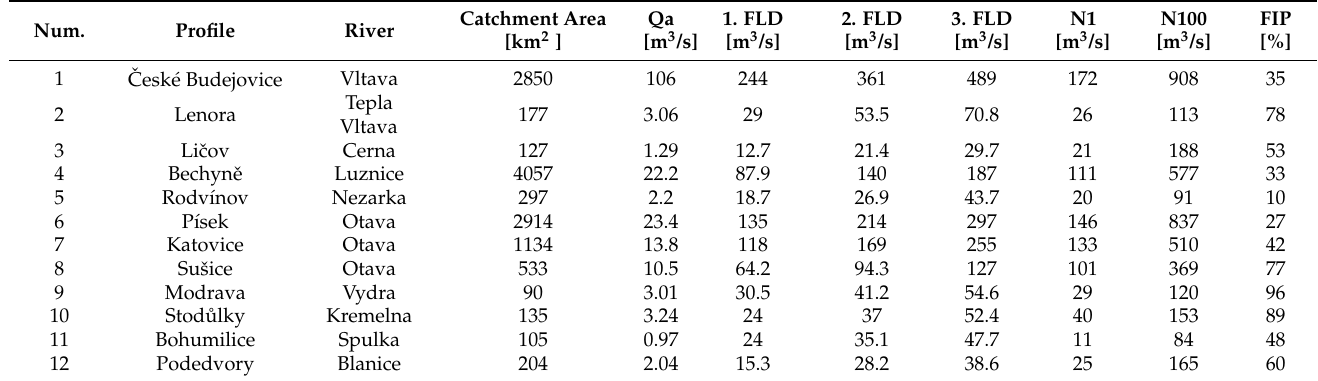
Table 2. Profile